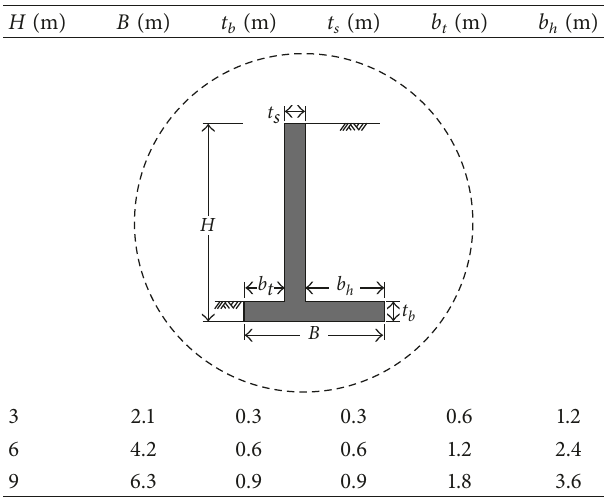
Table 1: Cantilever retaining wall dimensions